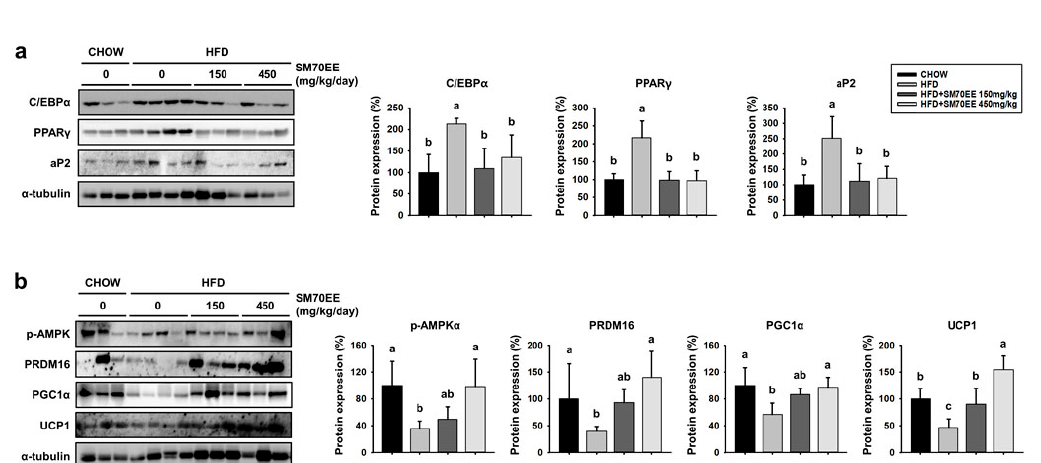
Figure 5. Treatment with SM70EE downregulates markers of adipogenesis and upregulates thermogenic markers in the WAT of HFD-fed mice. WAT from HFD-fed mice administered with SM70EE was analyzed for expression of adipogenic genes ( a ) and BAT-specific proteins ( b ). Specific bands were quantified and are presented as graphs. Mice were or were not administered with SM70EE (150 or 450 mg/kg/day) in their HFD for 6 weeks. Data are presented as mean ± SD ( n = 6). Values with different letters are significantly different, p < 0.05 (a > b > c).